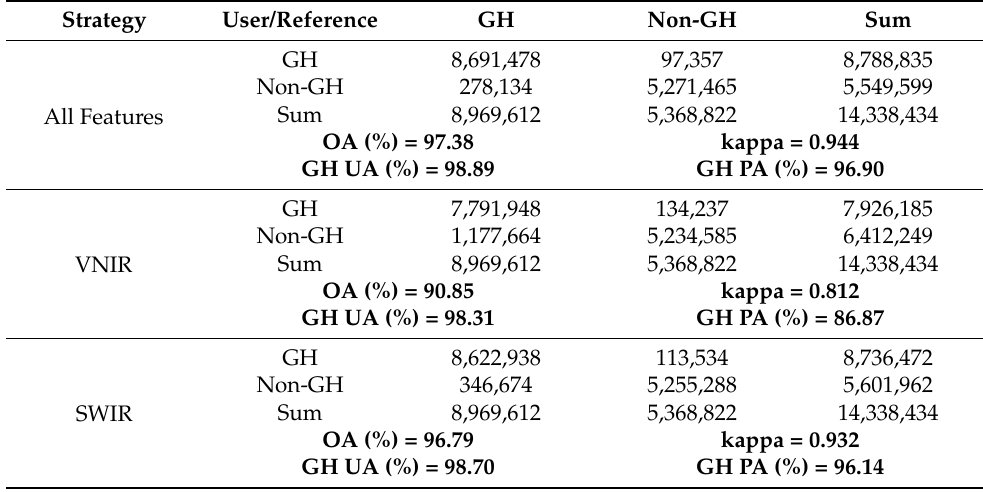
Table 5. Pixel-based confusion matrices from ground truth (TTA Mask) for the three strategies. Strategy User/Reference GH Non-GH Sum GH 8,691,478 All Features